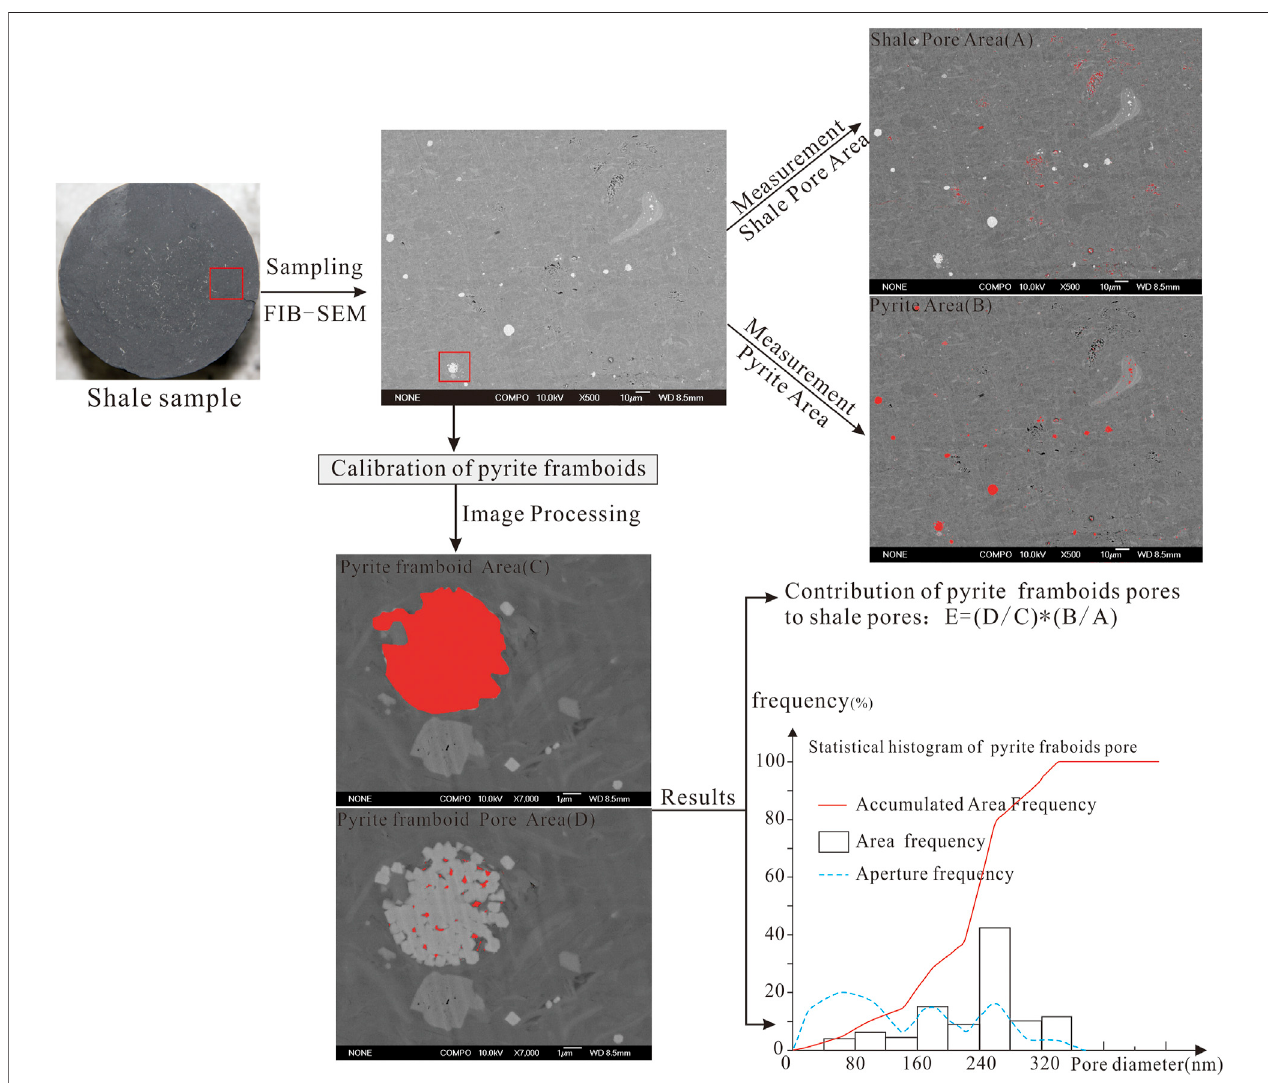
FIGURE 2 | Flowchart for quantitative characterization of pores in pyrite in the Longmaxi shale.